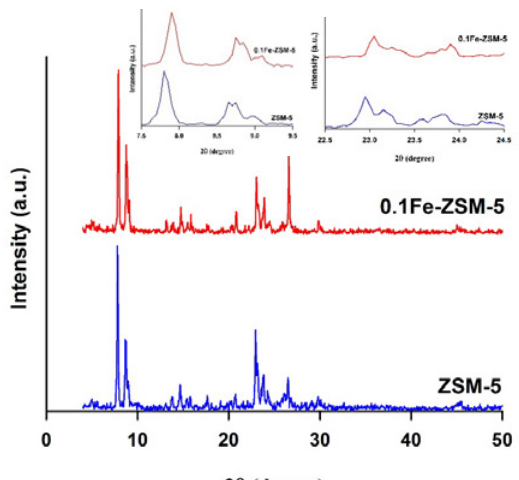
Fig. 2. The XRD patterns of the nanocatalysts (Inside patterns are the zoom in the range of 2θ=7.5-9.5 and b) 2θ=22.5-24.5). Table 2. Relative crystallinity and textural data (BET surface area, total volume of pores, microporous volume and mesoporous volume) of the nanocatalysts Sample